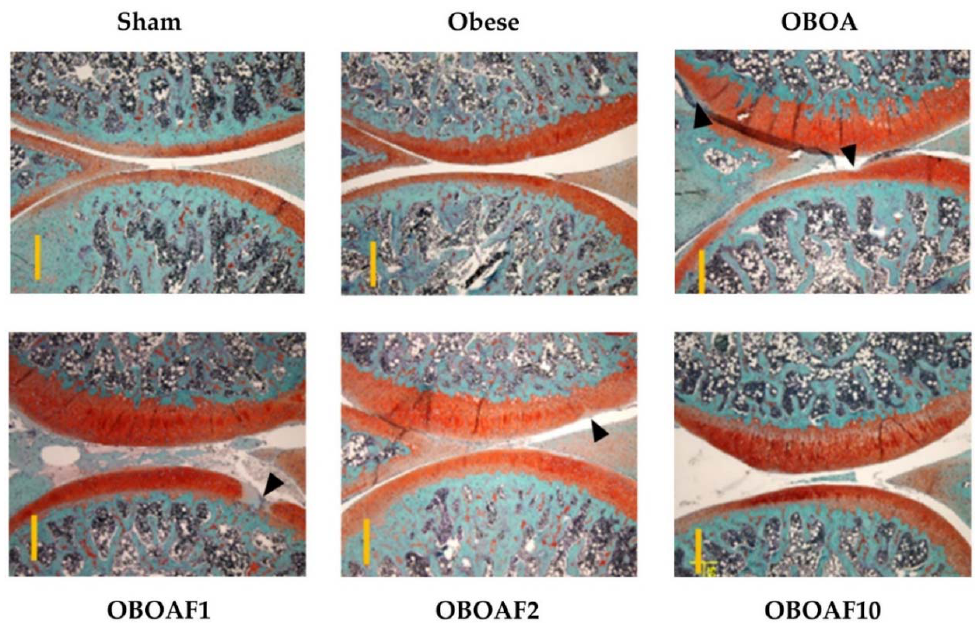
Figure 5. The histopathological difference between the knee joints in HFD-induced obese male rats with ACLT + MMx surgery induced OA using Fast Green and Safranin-O stains. The representative cartilage sections from the right medial condyle of the femur and tibia were stained. The specimens were observed with 40 × magnification. The scale bar length is 500 µ